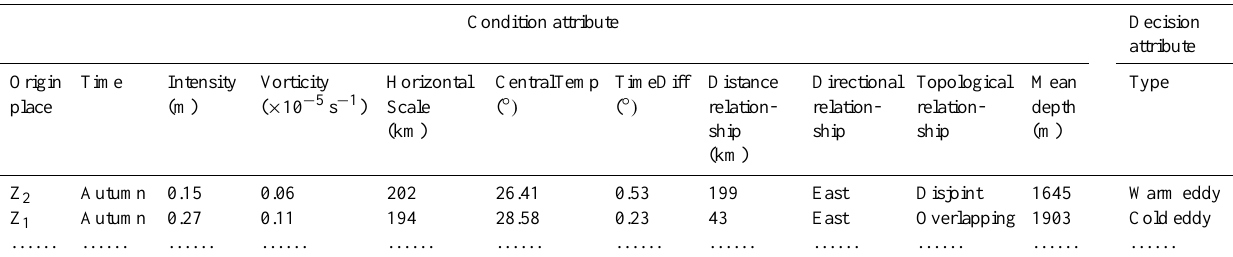
Table 4. Decision table constructed from spatial-temporal relationships of the type of mesoscale